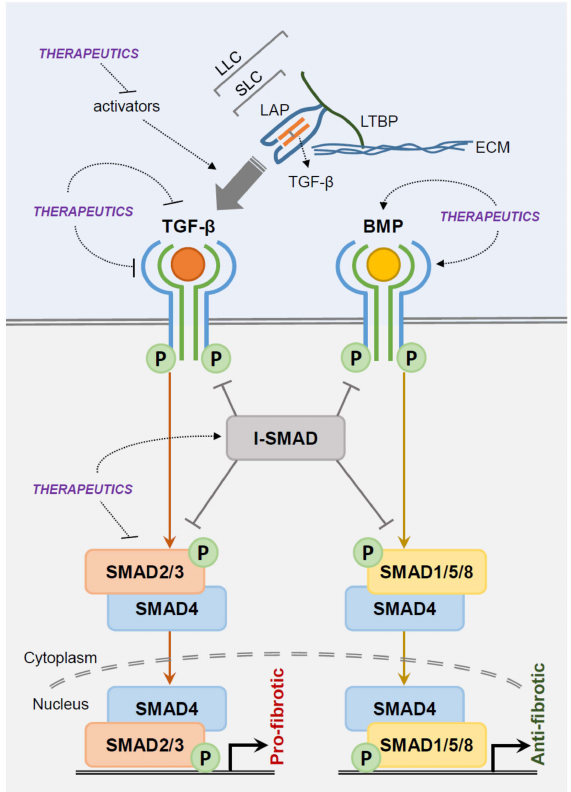
Figure 2. Potential therapeutic target sites in the TGF- β / BMP signaling pathway. (Orange and yellow circles / arrows, TGF- β ligands / signaling and BMP ligands / signaling, respectively).